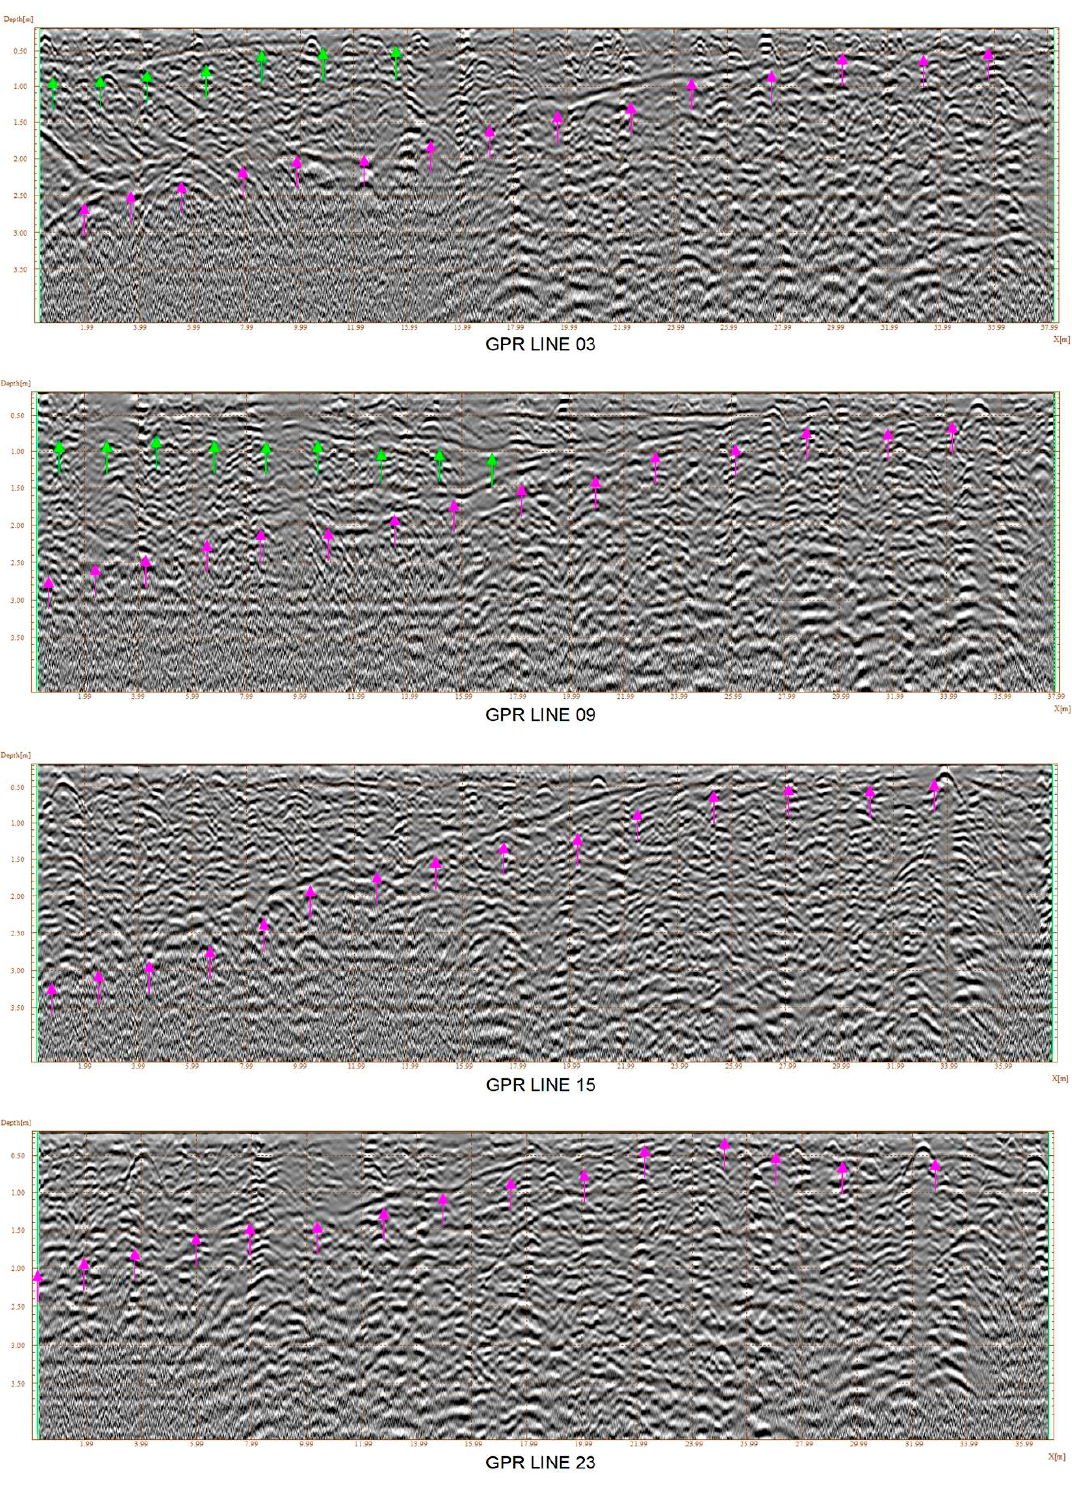
Figure 5. GPR radargrams across lines 03, 09, 15 and 23, drawn in Figure 4a, showing shallow sub-horizontal layers (green arrows) and deep steeper layers (pink arrows).